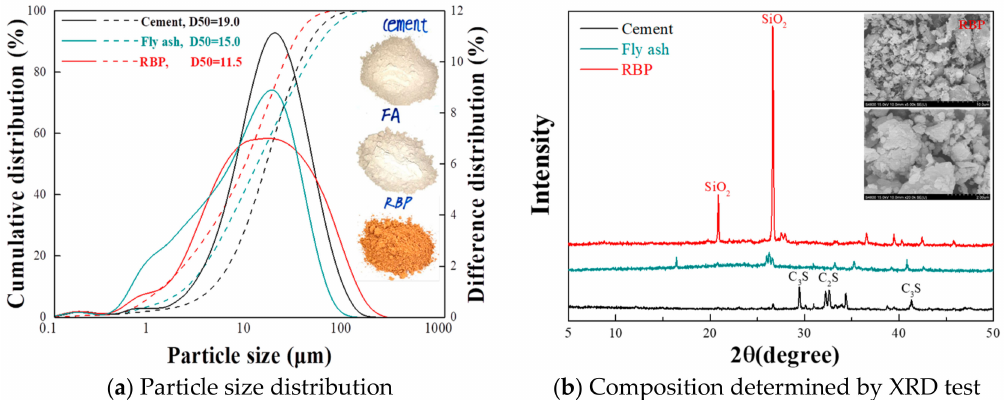
Figure 2. Properties of CBP used in the preparation of SHCC. ( a ) Particle size distribution; ( b ) Composition determined by XRD test.